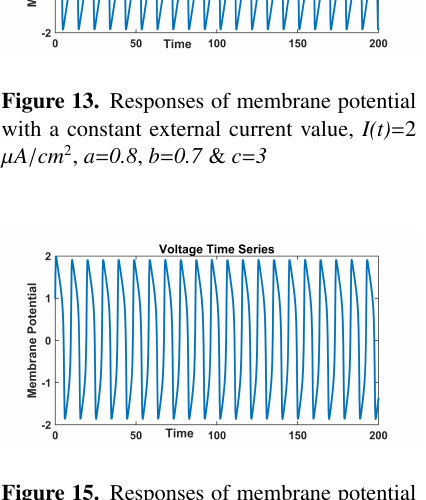
Figure 15. Responses of membrane potential with a constant external current value, I(t) = 3 µ A / cm 2 , a = 0.8 , b = 0.7 & c = 3